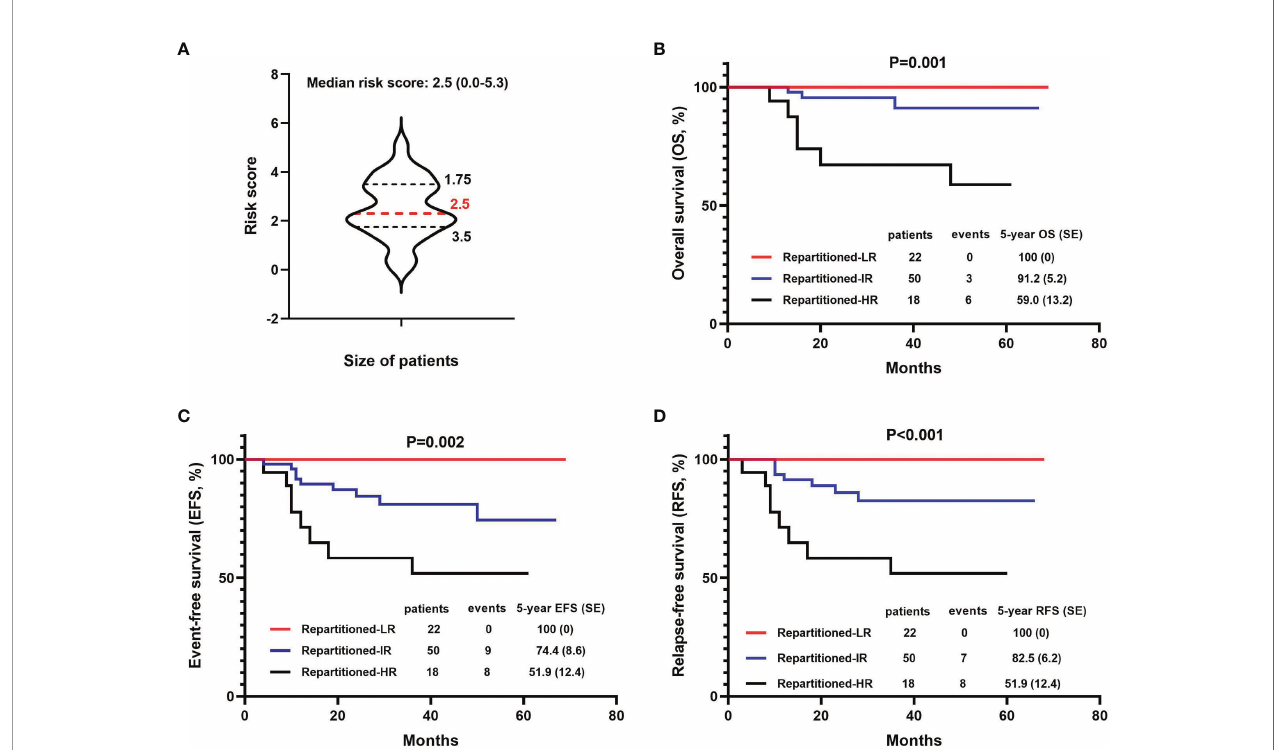
FIGURE 4 | Comparison of survival (OS, EFS, and DFS) based on the new risk strati fi cation systems. (A) The distribution of new risk scores in the patient cohort. (B – D) 5-year OS, EFS, and DFS based on 3 new levels of risk